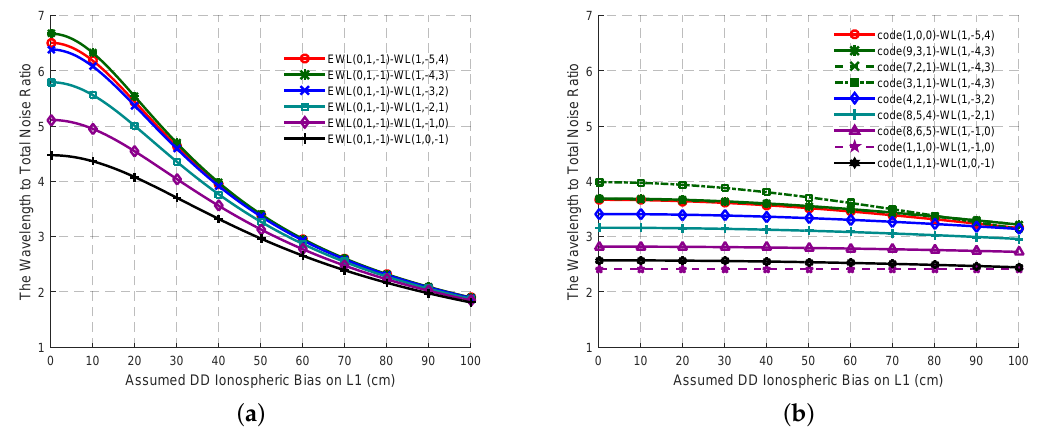
Figure 3. The variation trend of the wavelength to total noise ratio of the WL signal pairs for GF TCAR. ( a ) Signal pairs in Table 2; ( b ) Signal pairs in Table 3.